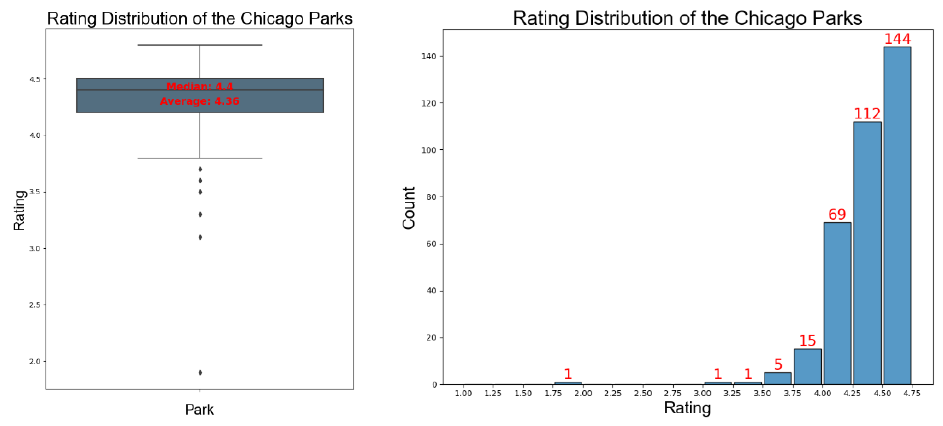
Figure 5. Boxplot and histogram of Chicago parks’